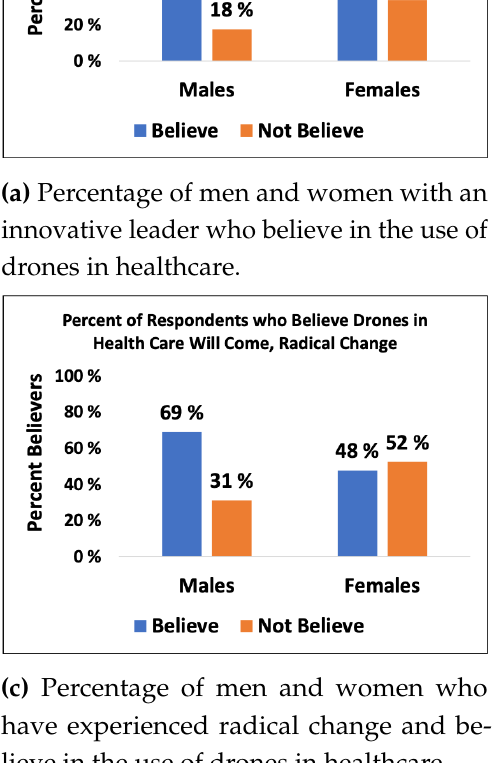
Figure 1. Interesting covariations that show ( a ) percentage of men and women with an innovative leader who believe in the use of drones in healthcare, ( b ) percentage of men and women without an innovative leader who believe in the use of percentage of men (69%) than women (59%) (p=0.015) believed that drones would be drones in healthcare, ( c ) percentage of men and women who have experienced radical change and believe in the use of 215 drones in healthcare, ( d ) percentage of men and women who have not experienced radical change and believe in the use of drones in